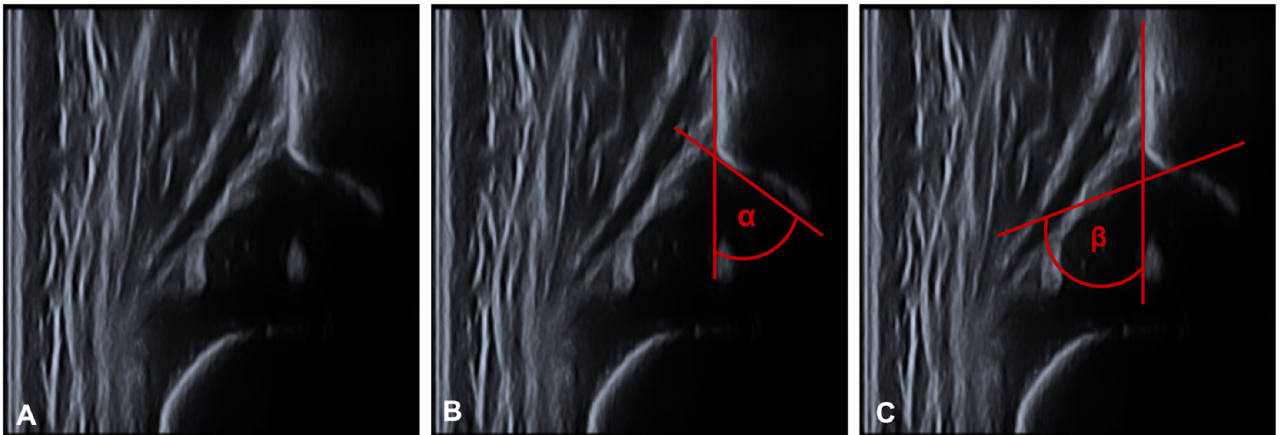
Figure 3. Shows the measurement of the α - and β -angle. ( A ) plain ultrasound image for anatomical identification and usability testing. ( B ) The tangent to the os ilium is the baseline for both angle determinations. For the α -angle, a tangent is drawn to the bony acetabulum starting from the lower edge of the os ilium ( C ) For the latter, a connecting line (display line) is drawn between the bony acetabular notch (turnover point) and the center of the acetabular labrum. The bony notch is located at the point where the acetabulum changes its profile from concave to convex. The angle between the two lines is called β -angle.